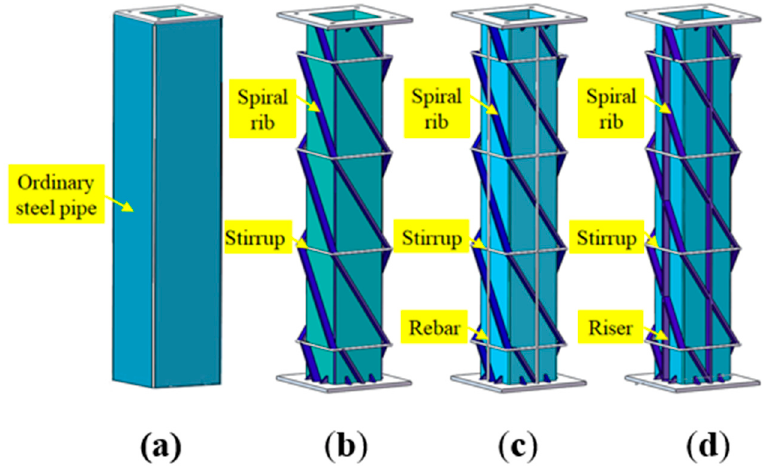
Figure 1. Core component forms. ( a ) Specimen 1; ( b ) Specimen 2; ( c ) Specimen 3; ( d ) Specimen 4.